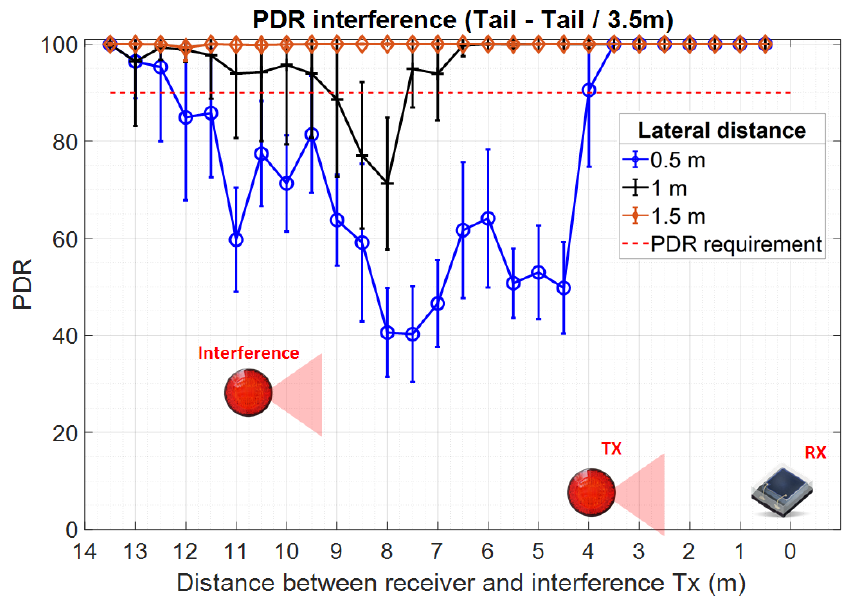
Figure 13. Experimental results showing the interference effect when the intended transmitter tail- light is located at 3.5 m with respect to the intended receiver, whereas the interference transmitter (tail-light) located at a lateral distance of 0.5, 1, and 1.5 m, moves longitudinally from 0 to 13 m.